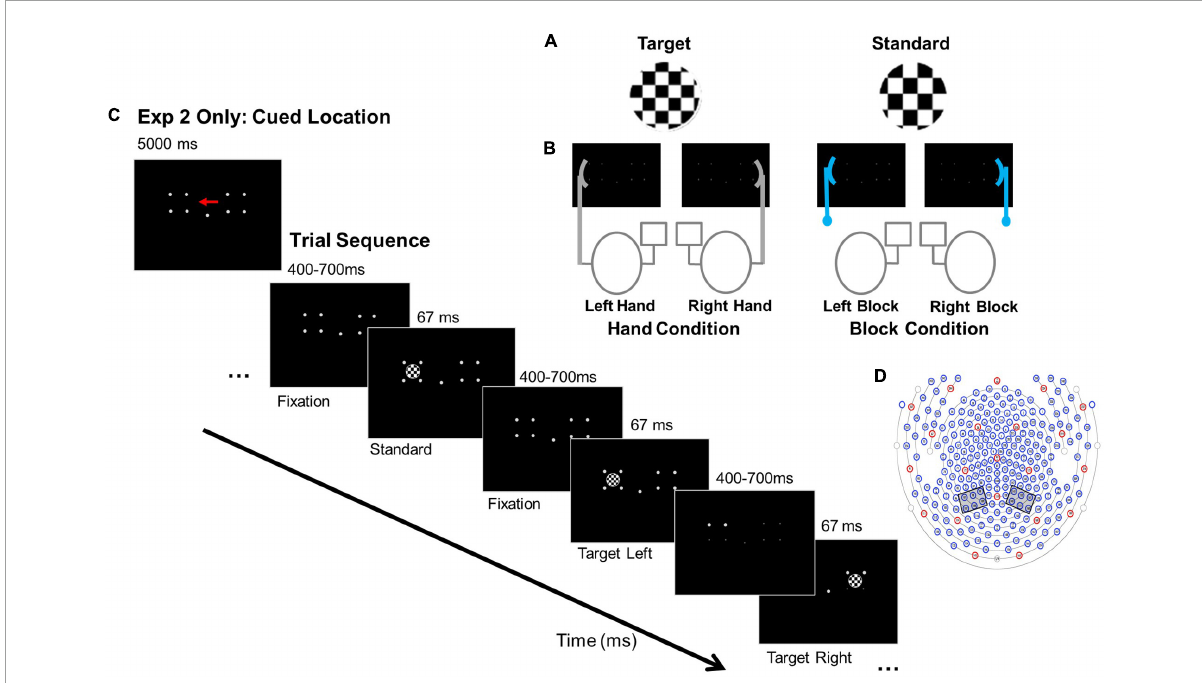
FIGURE1 Experimental conditions, paradigm, and electrode clusters. (A) Example stimuli. (B) Anchor conditions: Hand and Block. For example, in the “Right Hand” Hand condition the right hand is near one target location and responses are made with the left index finger. In the “Right Block” Block condition, the block is placed near the right target location and responses are made with the left index finger. (C) Paradigms for Experiments 1 and 2: Experiment 2 cue for focal attention to the left location and basic trial sequence. In Experiment 1 participants detected targets in left and right locations. (D) 256- channel locations for EGI Hydrocel Geodesic EEG System 300 (Electrical Geodesic Inc., Eugene, OR). Left and right hemisphere electrode clusters are indicated by the gray